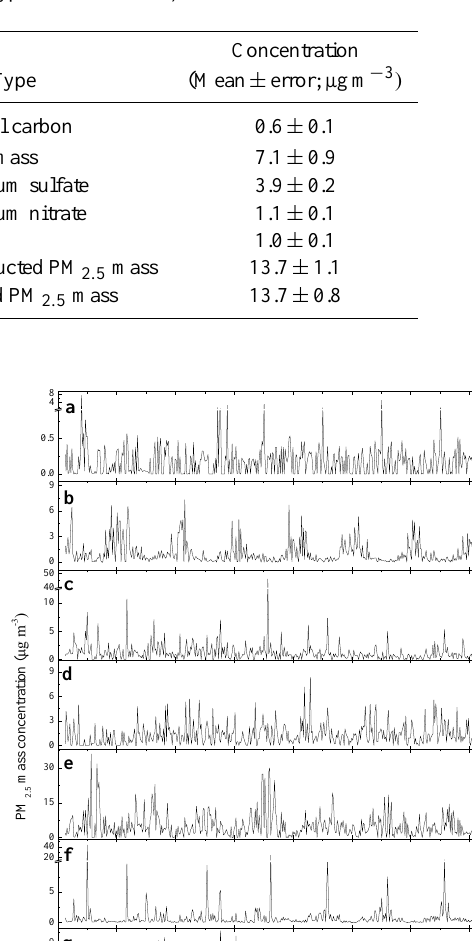
Table 1. Diagnostic ratio of PM 2 . 5 chemical species and major aerosol types in Little Rock, Arkansas.